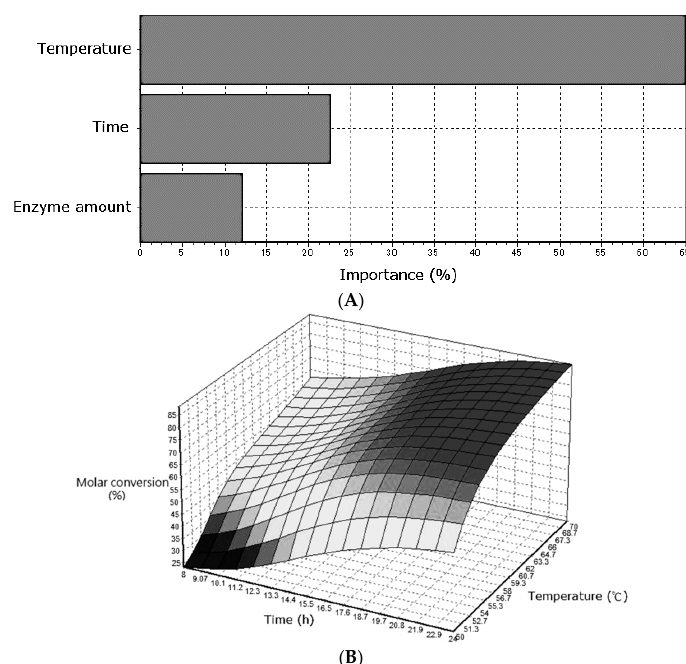
Figure 5. Influence of experimental variables on enzymatic synthesis of 2 ‐ ethylhexyl salicylate. ( A ) Importance of experimental variables in 2 ‐ ethylhexyl salicylate synthesis. ( B ) The relationships between the molar conversion of 2 ‐ ethylhexyl salicylate and reaction parameters (time and temperature).